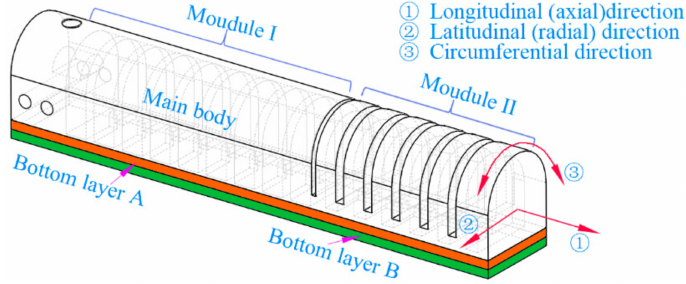
Figure 1. Structural schematic diagram of the proposed SPA.